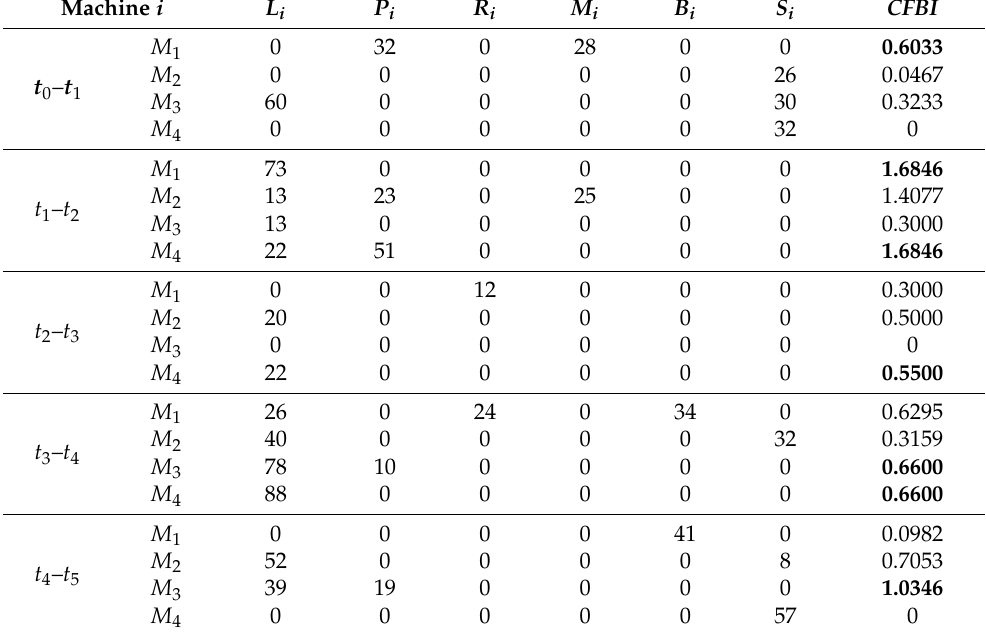
Table 8. Data of subsystem bottleneck.